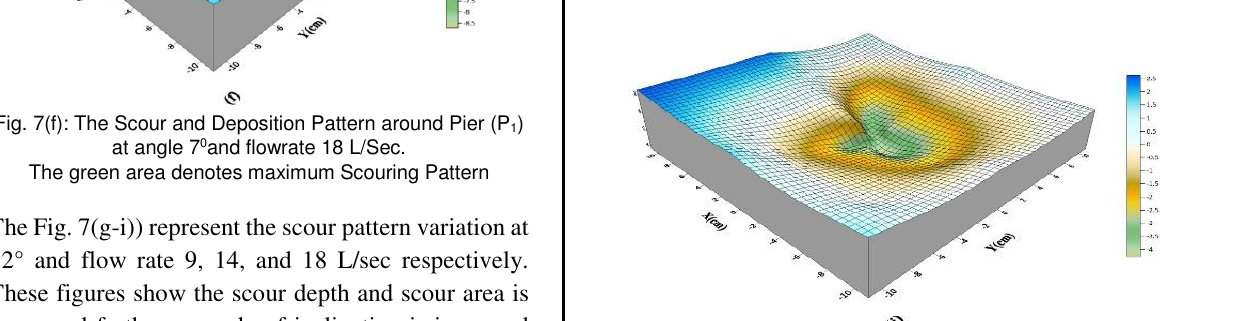
Fig. 7(i): The Scour and Deposition Pattern around Pier (P 1 ) at angle 12 0 and flowrate 18 L/Sec. The green area denotes maximum Scouring Pattern Fig. 7(j-o) represent scour pattern at angle of inclination 15˚and 19˚ and flow rate 9,14, and 18 L/sec respectively. These figures show scour area and depth around pier is reduced as angle of inclination is increased to 15˚. It becomes minimum at an angle of inclination 19˚.